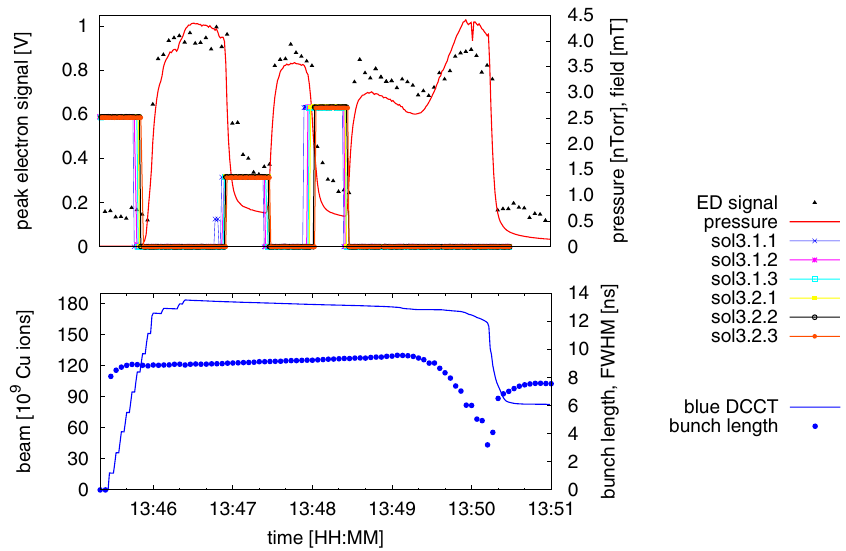
FIG. 18. (Color) Effect of the solenoid field at BI12, where 90% of the entire section is covered with solenoids. A solenoidal field of 1.35 mT is enough to decrease the pressure by about a factor 7. No further improvements are noticeable when the field is increased to 2.7 mT (see text). At about 13:49:30, the acceleration ramp starts, the bunch length is reduced, and pressure and electron signals increase. Half of the beam is lost while crossing the transition energy (13:50:05), after which the electron cloud disappears because of the low bunch intensity